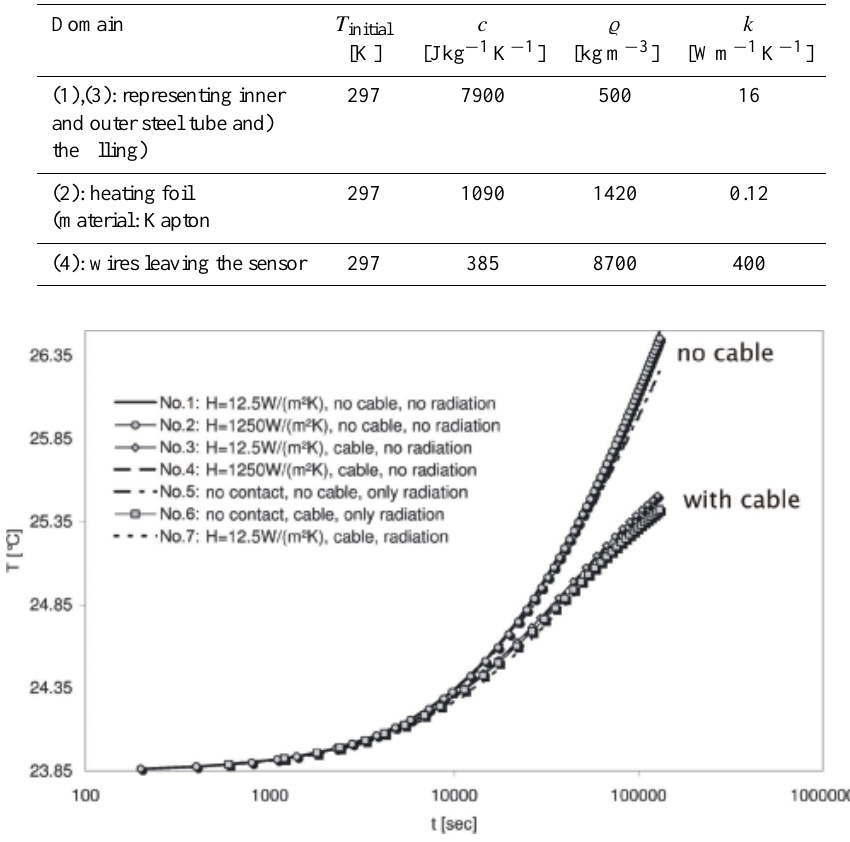
Fig. 13. Temperature response of the hollow cylindrical LNP01-sensor at the measurement point due to heating in a very low conductivity sample with λ = 0 . 002Wm − 1 K − 1